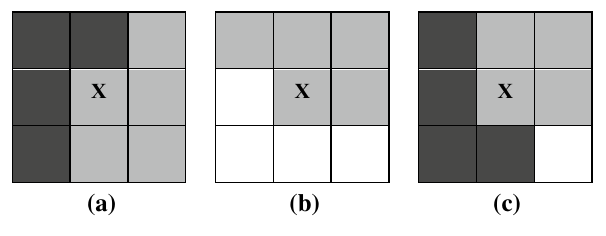
Fig. 1 Mapping process for pixel classification